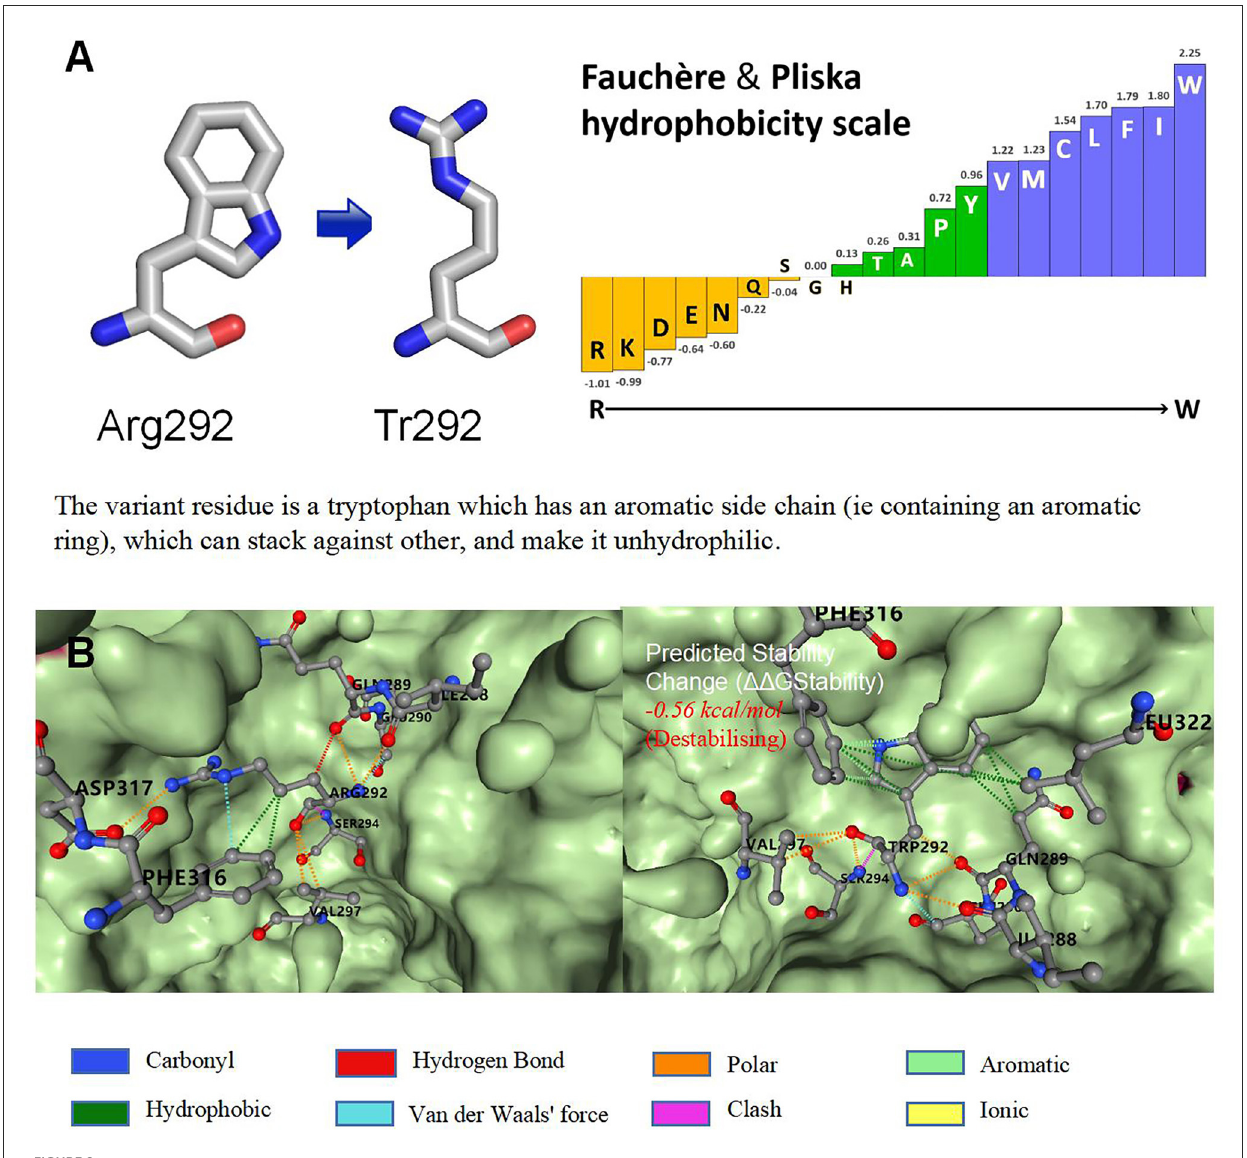
FIGURE2 Function and stability prediction of variants. (A) Prediction of p.Arg292Trp function. (B) Prediction of variant stability.